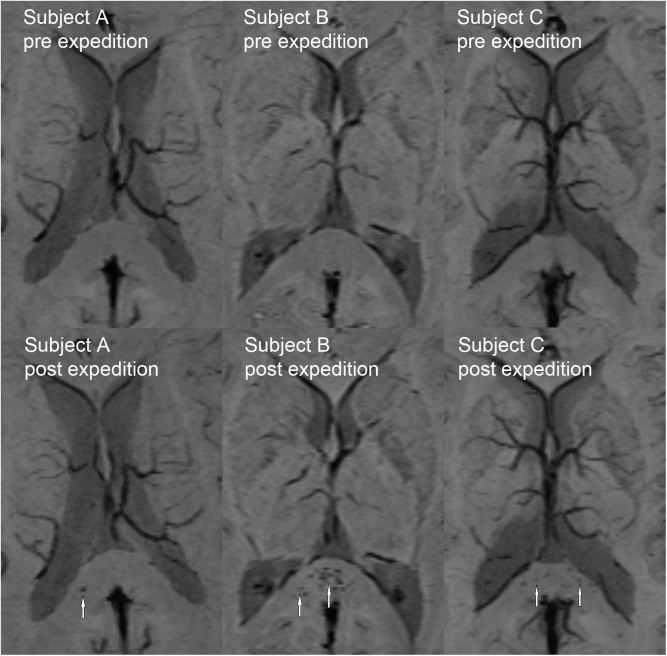
Imaging findings pre- and post-expedition in subjects with new microhemorrhages after the climb.Subject A: Comparison of SWI (MinIP) in pre- and post-expedition MRI shows a new solitary microhemorrhage (indicated by arrow). SWI of Subject B and SWI (MinIP) of subject C show multiple new microhemorrhages of the corpus callosum visible in post-expedition MRI (arrows).